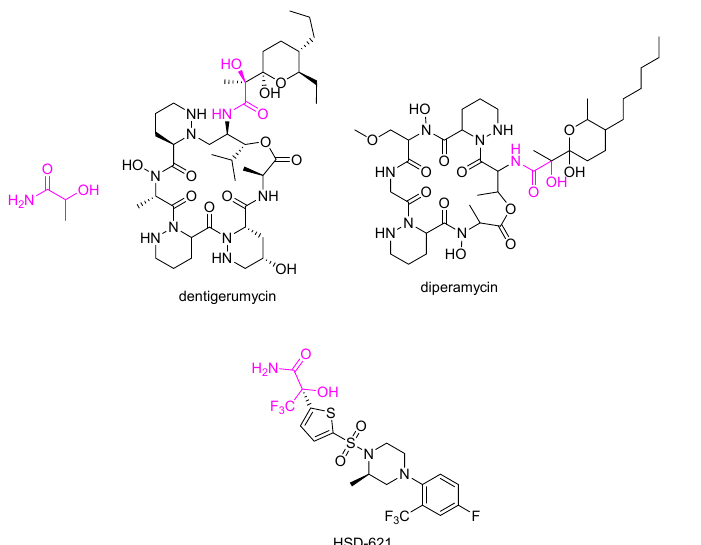
Figure 1. Hydroxypropanamide fragment, amide and sulfonamide pharmacophores in selected bioactive compounds.